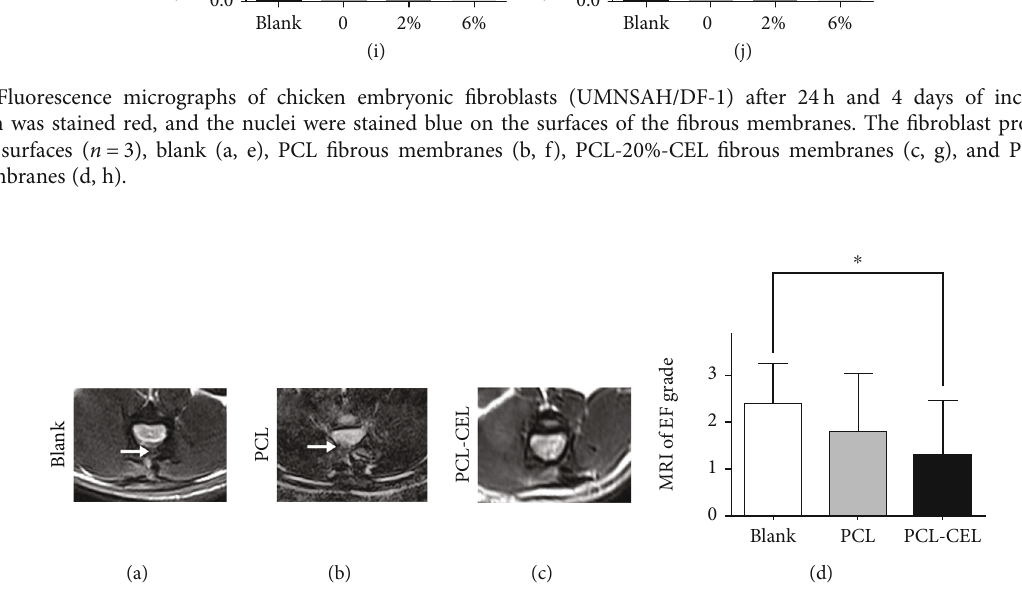
Figure 3: Magnetic resonance imaging (MRI) of the spine. MRI images of epidural fi brosis in the control group (a), the PCL group (b), and the PCL-CEL group. Epidural fi brosis grades based on MRI images (d). White arrows indicate epidural fi brosis. ∗ P < 0 : 05 . EF: epidural fi